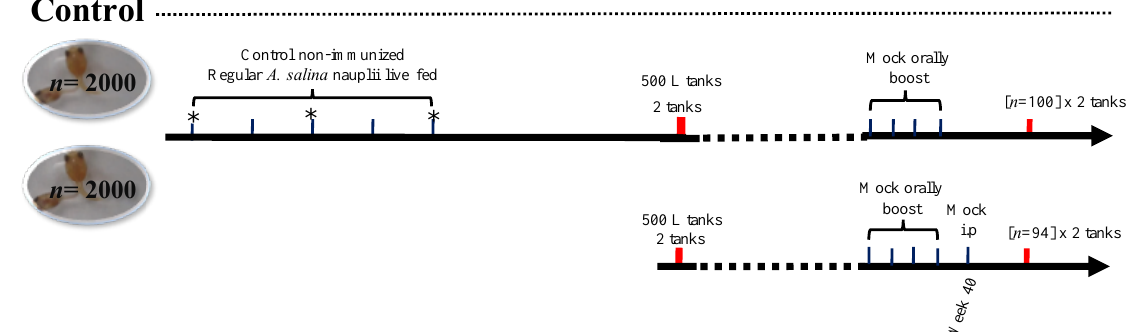
Figure 1. Immunization and challenge experimental design. Lumpfish larvae were immunized at 1 wph. At 8 wph, the fish were distributed in 500 L tanks. Lumpfish were boosted at 36 wph and challenged with V. anguillarum at 45 wph. * Larvae samples were collected at weeks 0, 2, 4 post-immunization for RNA extraction.